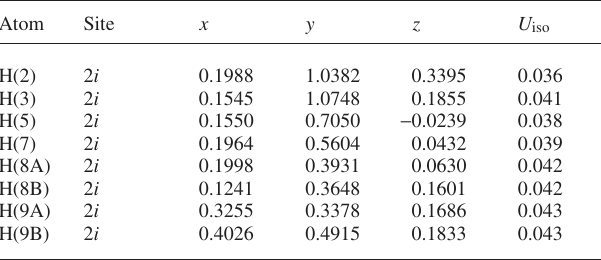
Table 2. Atomic coordinates and displacement parameters (in Å 2 )